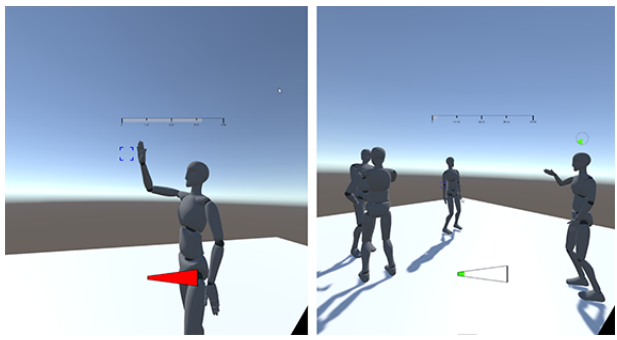
Figure 7. Anticipation cues: When recording an animation, the cues are displayed in the field of view of the user at the target